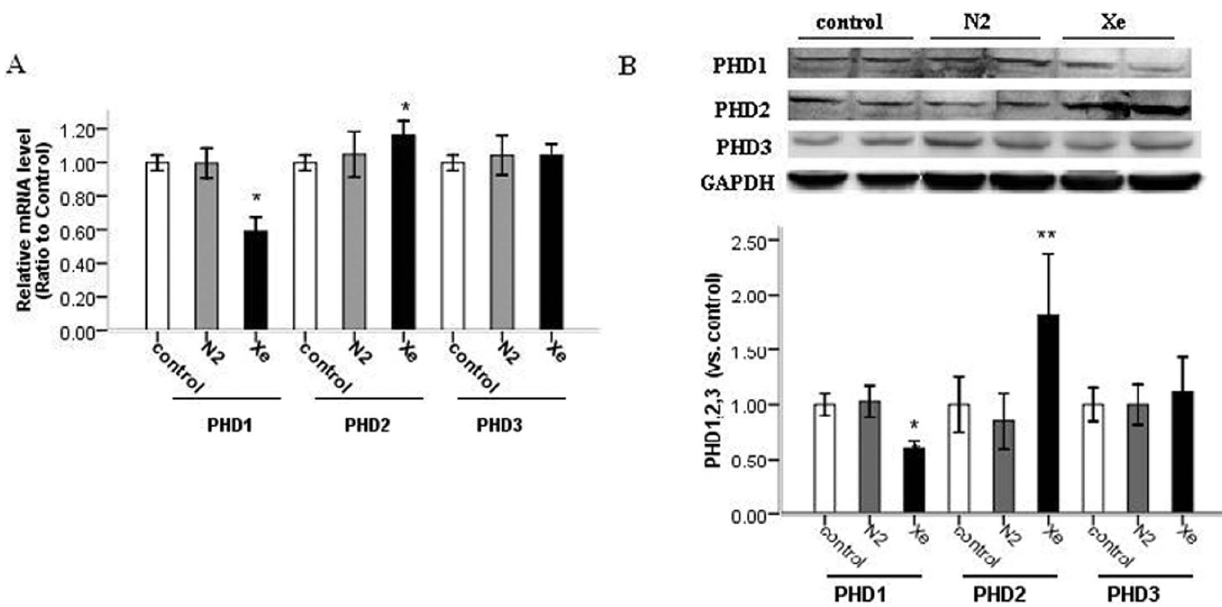
Figure 6. Xe pretreatment up-regulated PHD2, down-regulated PHD1, but did not affect the expression of PHD3. A: the relative mRNA levels of PHD1, PHD2 and PHD3 by real-time reverse transcriptase (RT)-PCR analysis in kidney 24 hrs after 70% N 2 or 70% Xe pretreatment alone. B: representative images of western blot analysis of PHD1, PHD2 and PHD3 in kidney 24 hrs after N 2 or Xe pretreatment alone. Relative intensities of PHD1, PHD2 and PHD3 blots normalized to control. *P , 0.05 vs . control group.